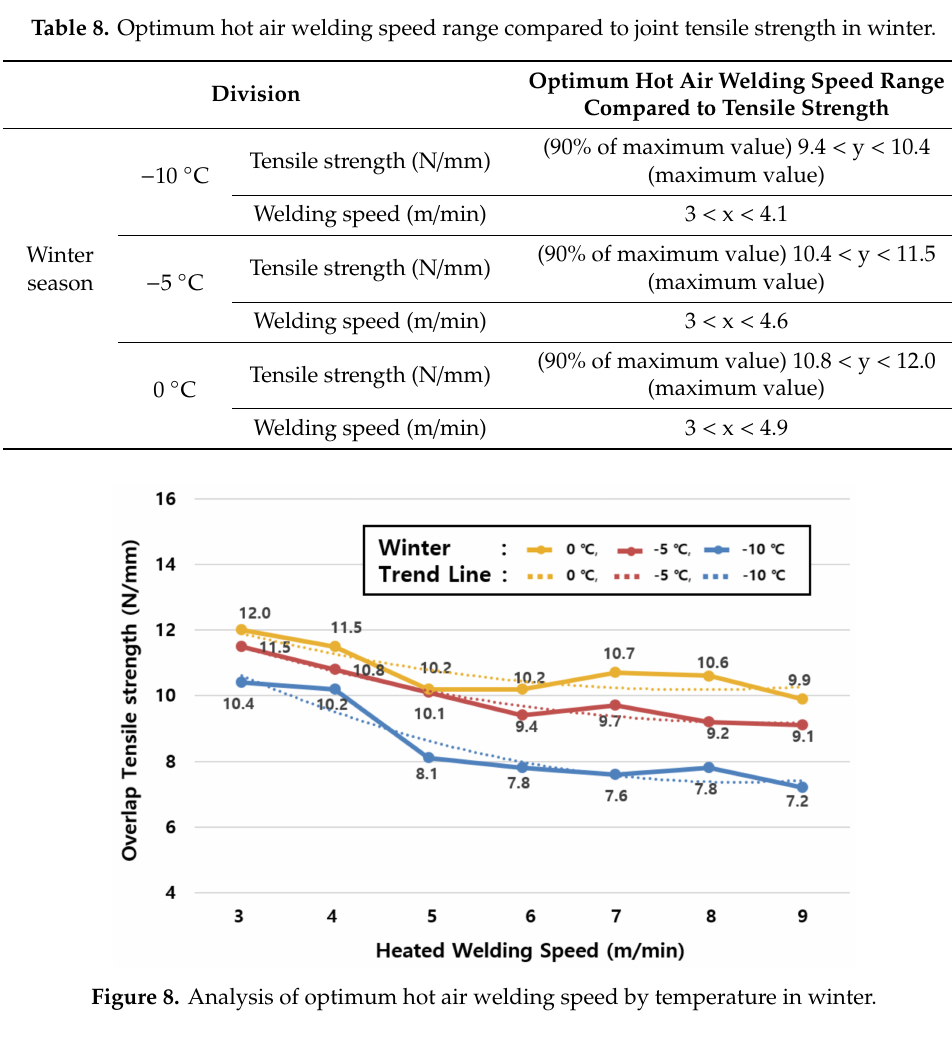
Table 7. Regression analysis results of hot air welding speed according to the temperature in winter. Division Regression Equation R 2 = reliability − 10 ◦ C y = 0.1155x 2 − 1.456x + 11.957 Winter season